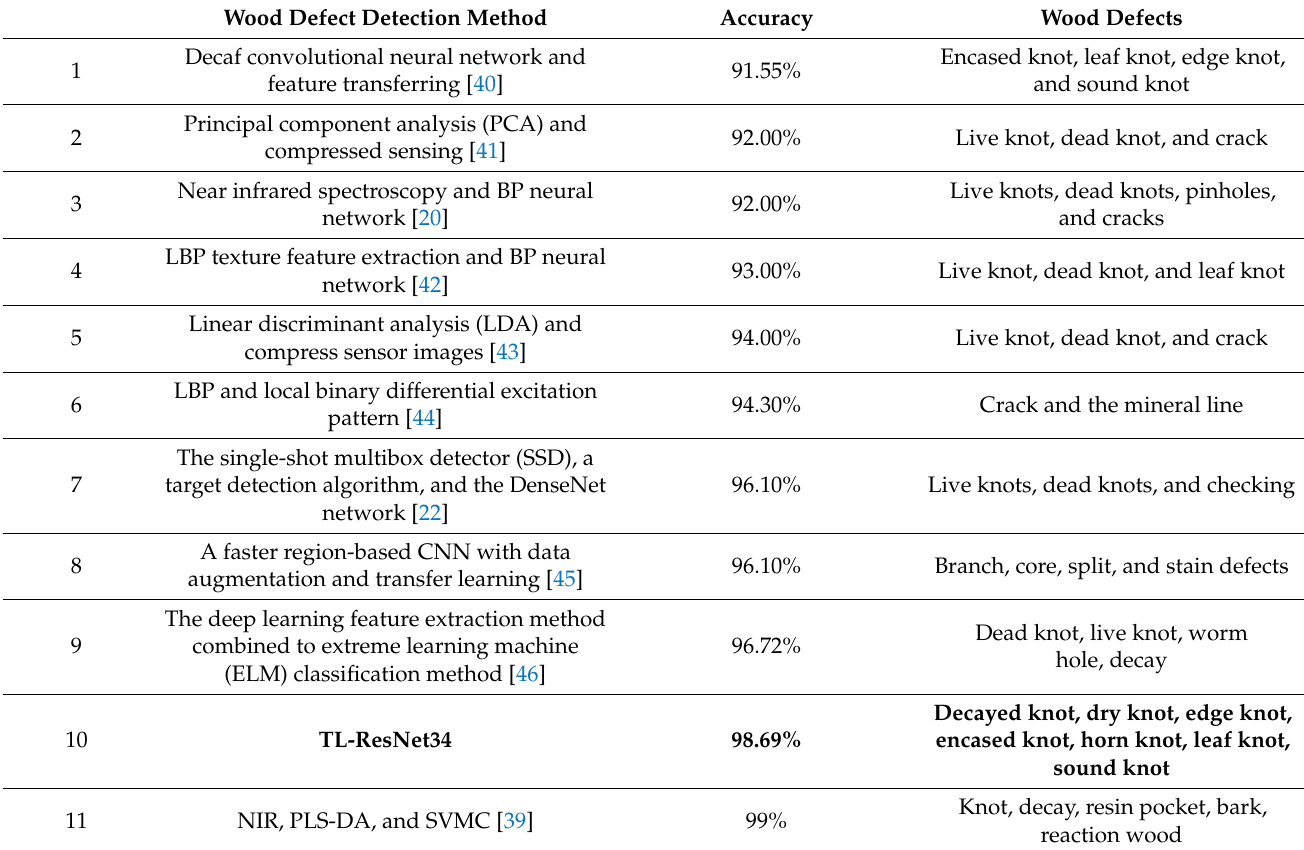
Table 7. Comparison of the proposed method with previous detection methods for wood surface defects. Our method is